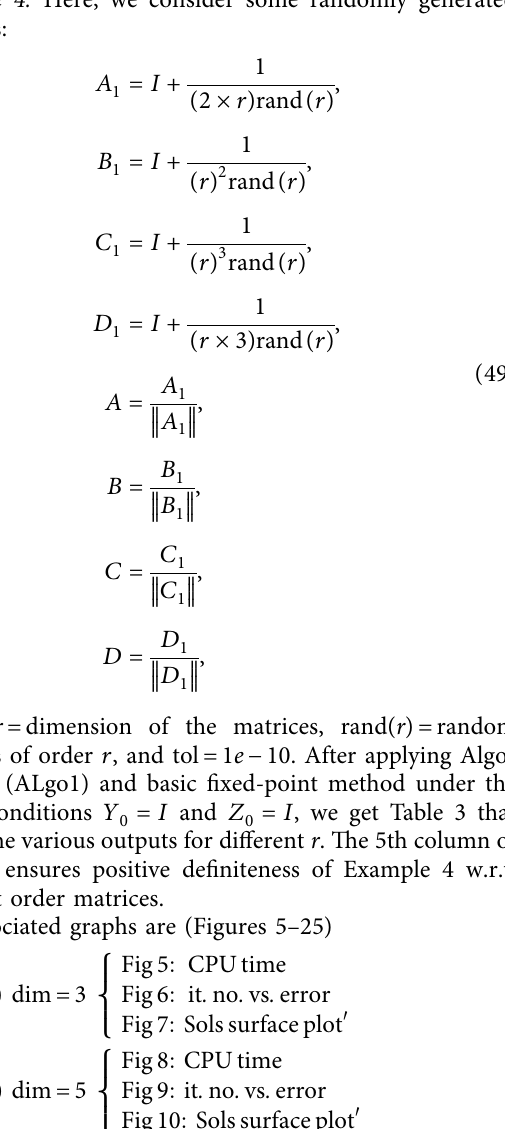
Fig 5 : CPU time Fig 6 : it . no . vs . error Fig 7 : Sols surface plot ′ Fig 8 : CPU time Fig 9 : it . no . vs . error Fig 10 : Sols surface plot ′ Fig 11 : CPU time Fig 12 : it . no . vs . error Fig 13 : Sols surface plot ′ Fig 14 : CPU time Fig 15 : it . no . vs . error Fig 16 : Sols surface plot